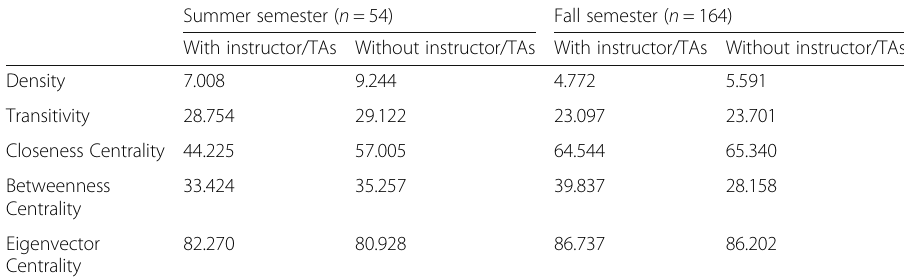
Table 2 Results of social network analysis on online Q & A Summer semester ( n =